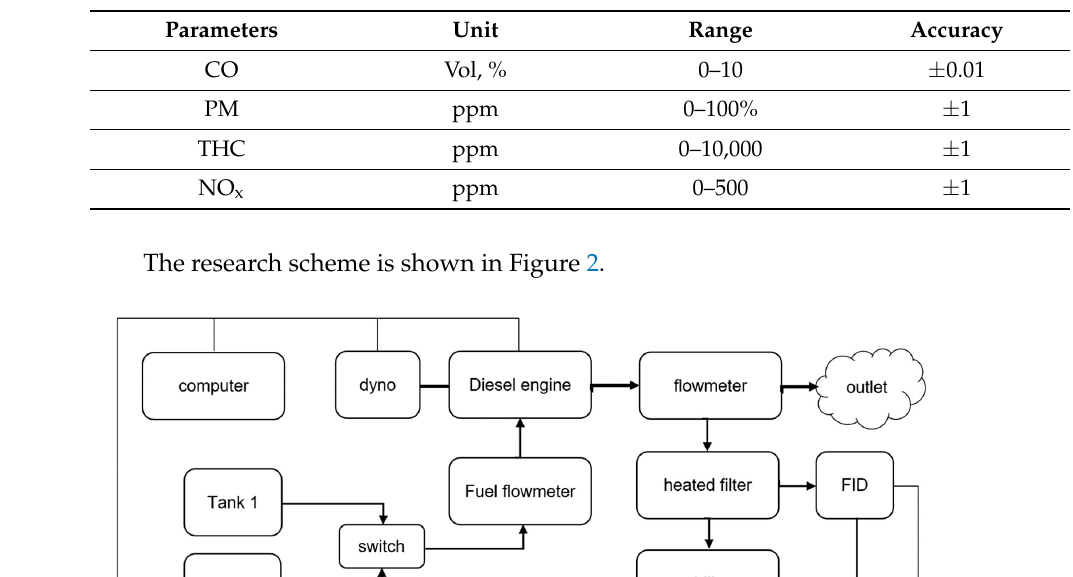
Table 5. Technical specifications of the gas analyzer employed in this study.